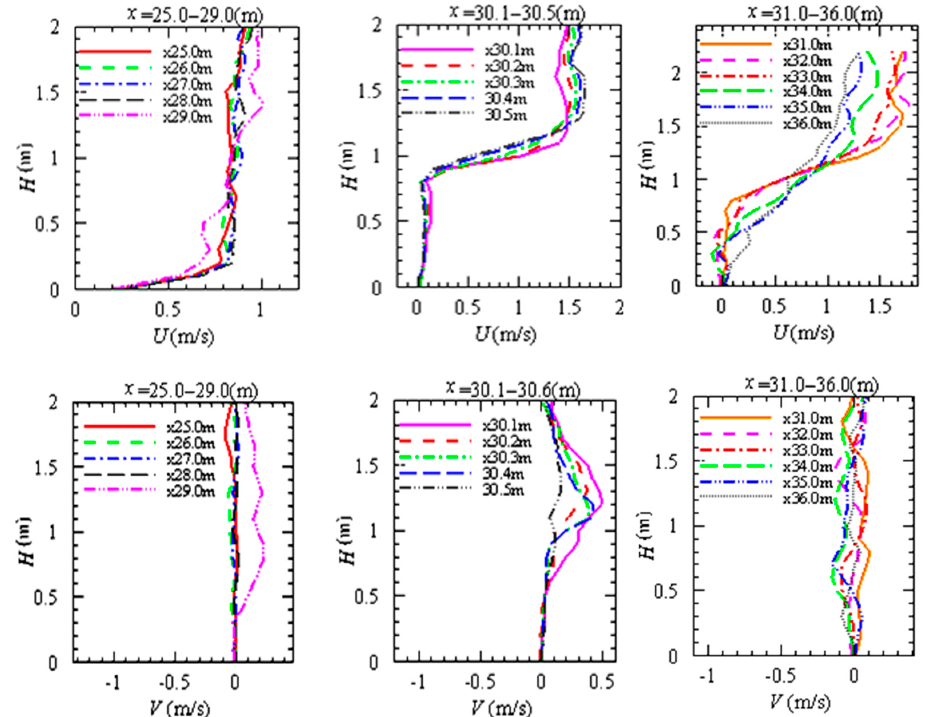
Figure 12. Characteristics of longitudinal and vertical flow fields when the vertical section of the pore is 0.9m × 0.9m; solid line: x = 25.0; x = 30.1 x = 31.0; dashed line: x = 26.0; x = 30.2 x = 32.0; dotted line: x = 27.0; x = 30.3x = 33.0. Long dashed line: x = 28.0; x = 30.4 x = 34.0; double dotted line: x = 29.0; x = 30.5 x = 35.0; dotted line: x = 36.0.